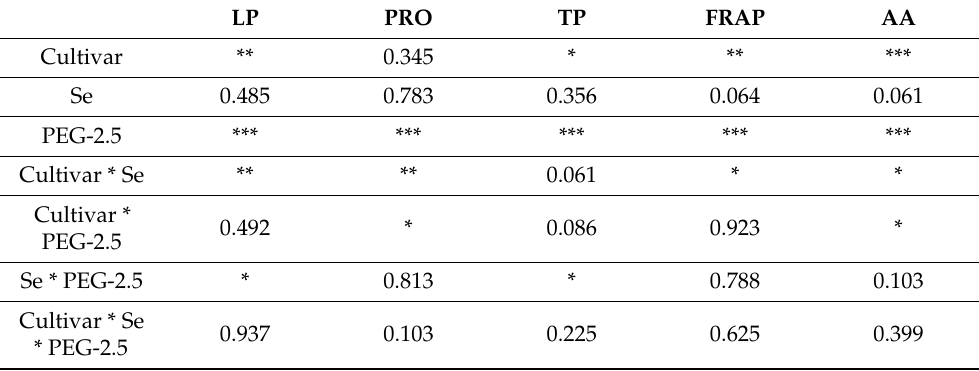
Table 2. Results of ANOVA for lipid peroxidation product (LP), proline content (PRO), total phenols (TP), total antioxidant activity (FRAP), and ascorbic acid (AA). Significance of effects is denoted with